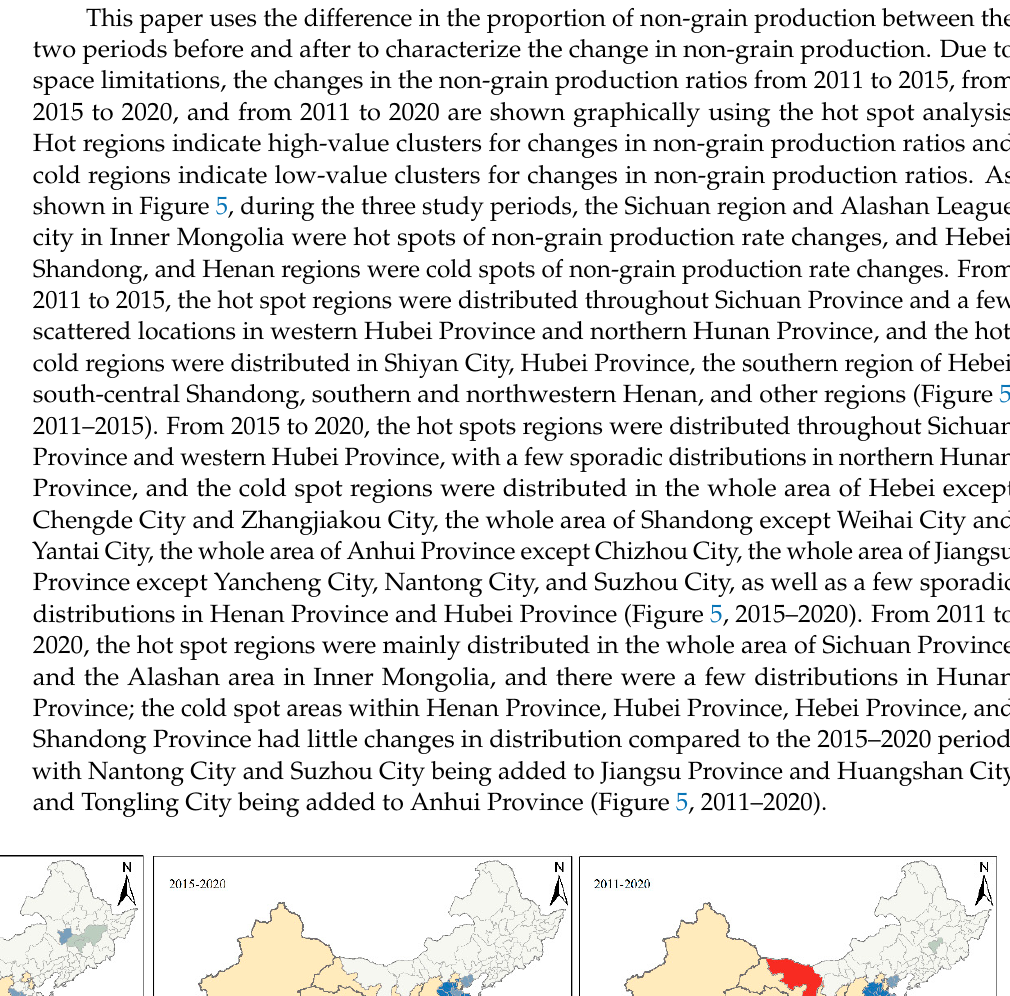
Figure 4. The ratio of non-grain production and the proportion of grain production to total national production in 2011, 2016, and 2020.